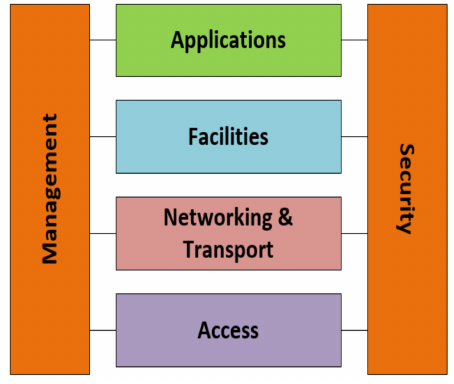
Figure 3. ITS protocol